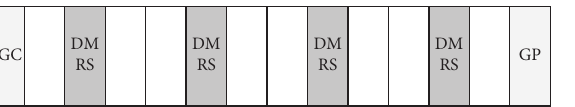
Figure 5: LTE-V frame